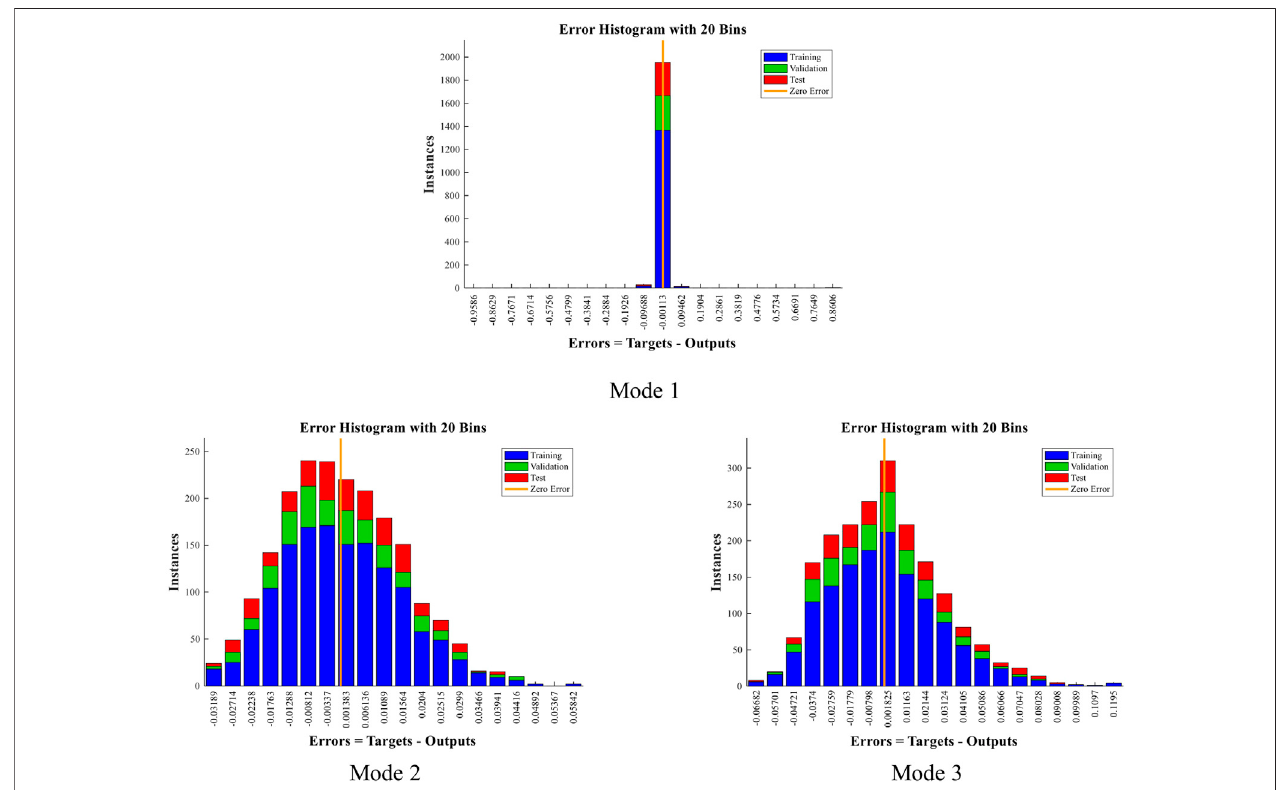
FIGURE 5 | Error histogram of R-M-ANN model training.